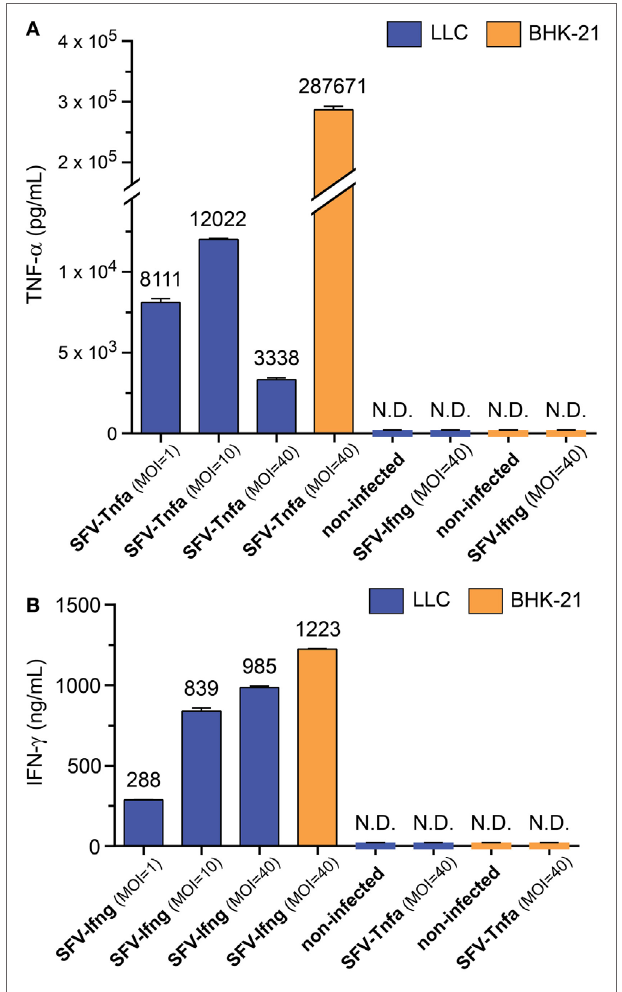
FigUre 6 | Semliki Forest virus (SFV)-encoded cytokines are produced and secreted by cancer cells. Baby hamster kidney (BHK-21) and Lewis lung carcinoma (LLC) cells were infected with either SFV-Ifng or SFV-Tnfa at MOI = 1, MOI = 10, or MOI = 40 (determined using BHK-21 cells). The level of secreted (a) TNF- α or (B) interferon (IFN)- γ in the cell culture medium was determined using Luminex bead-based assay at 24 h after infection and is shown on the y -axis. The cytokines were undetectable in both the negative controls of non-infected cells and the cultures that were infected with a mismatched SFV that did not encode the cytokine of interest. N.D.—not detectable. Two independent experiments were performed in duplicates. Data from one representative experiment is shown. The bars represent the mean values of duplicates ±